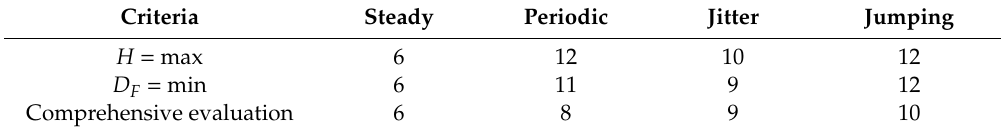
Table 3. Optimal wavelet decomposed level of di ff erent types of observed signal.